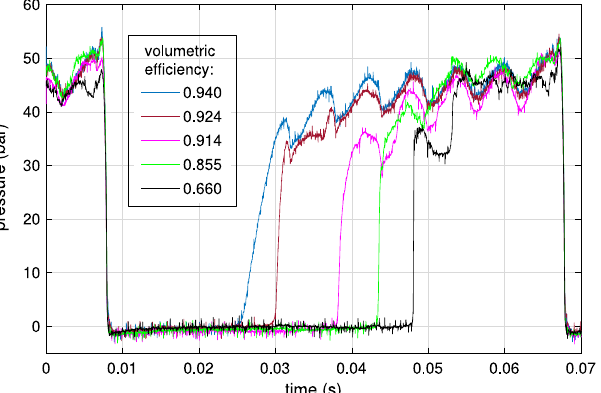
Figure 16. Experimental tooth space pressure with plates type B and different levels of incomplete filling at 1000 rpm. filling at 1000